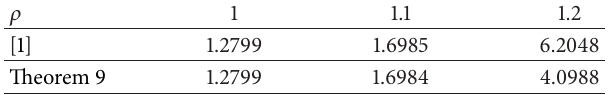
Table 2: Different minimum 𝛾 for robust switched linear filter.